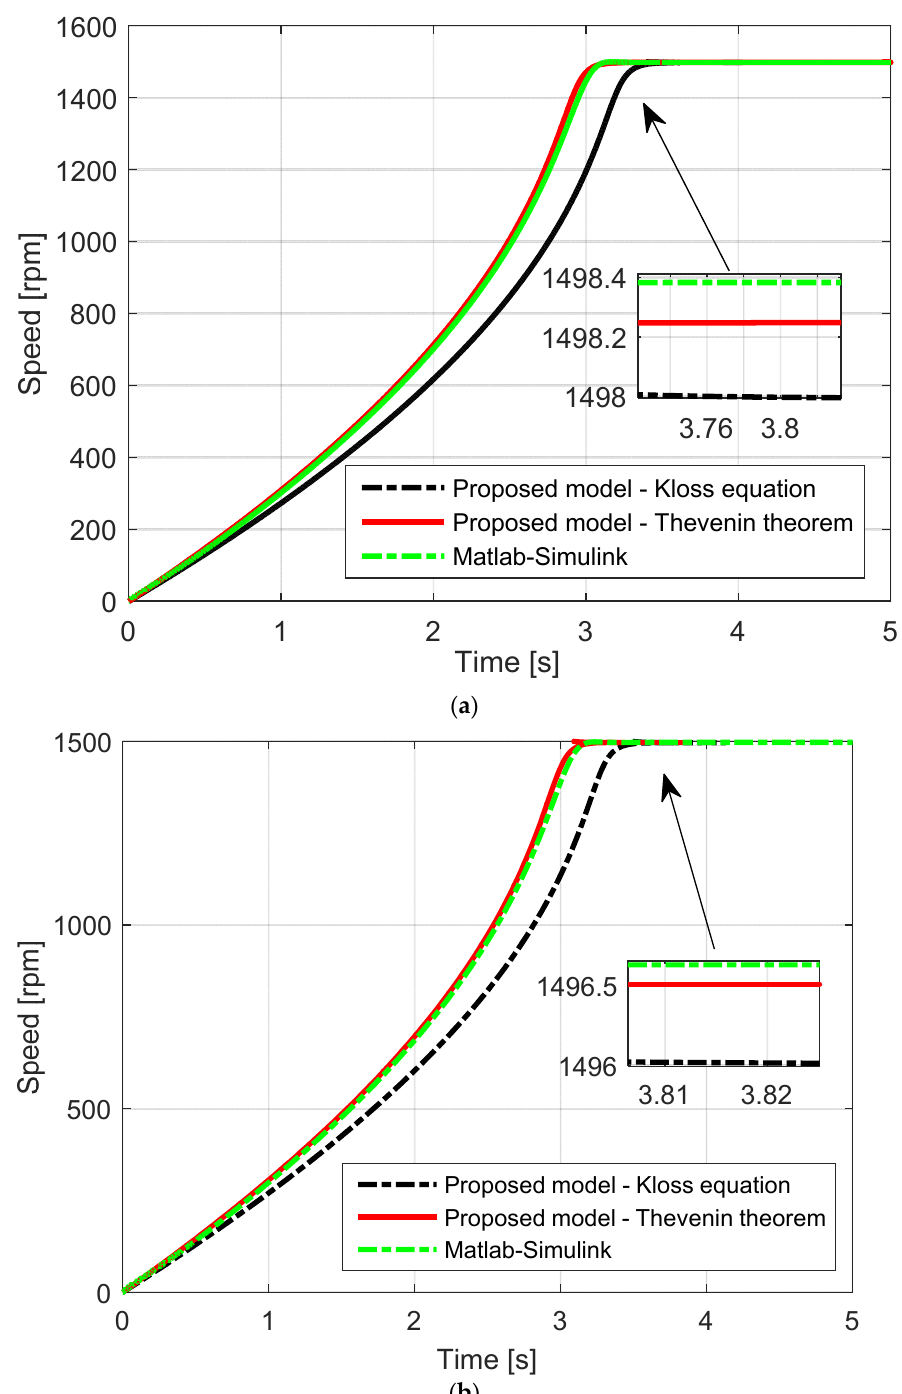
Figure 1. Speed-time curve of the IM ( J = 4.9 kgm 2 , B = 0.1, U = 200 V) during no-load direct start-up: ( a ) B = 0.1, and ( b ) B = 0.2.